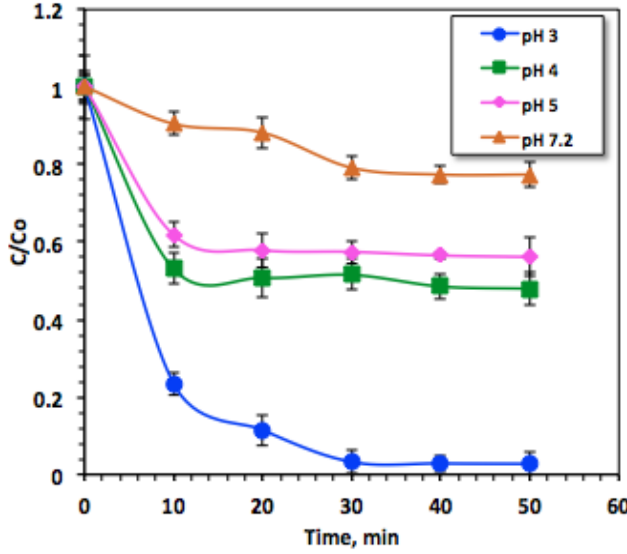
Figure 7. Effect of pH of the aqueous matrix on the photo-Fenton system.